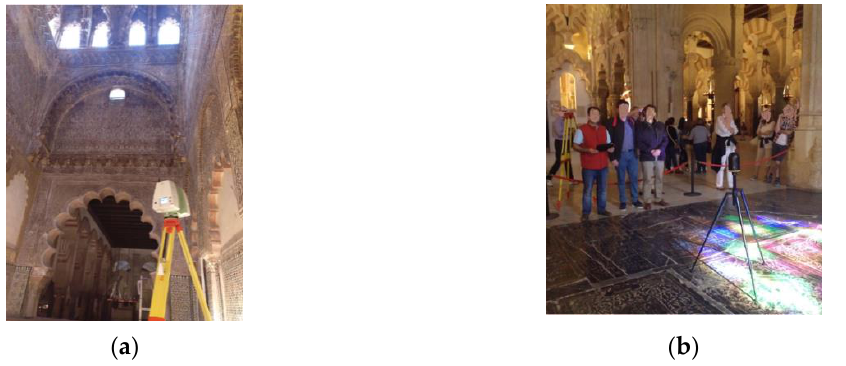
Figure 13. Scanners used to obtain the point cloud: ( a ) Leica C10; ( b ) Leica BLK360. Source: Own photographs.